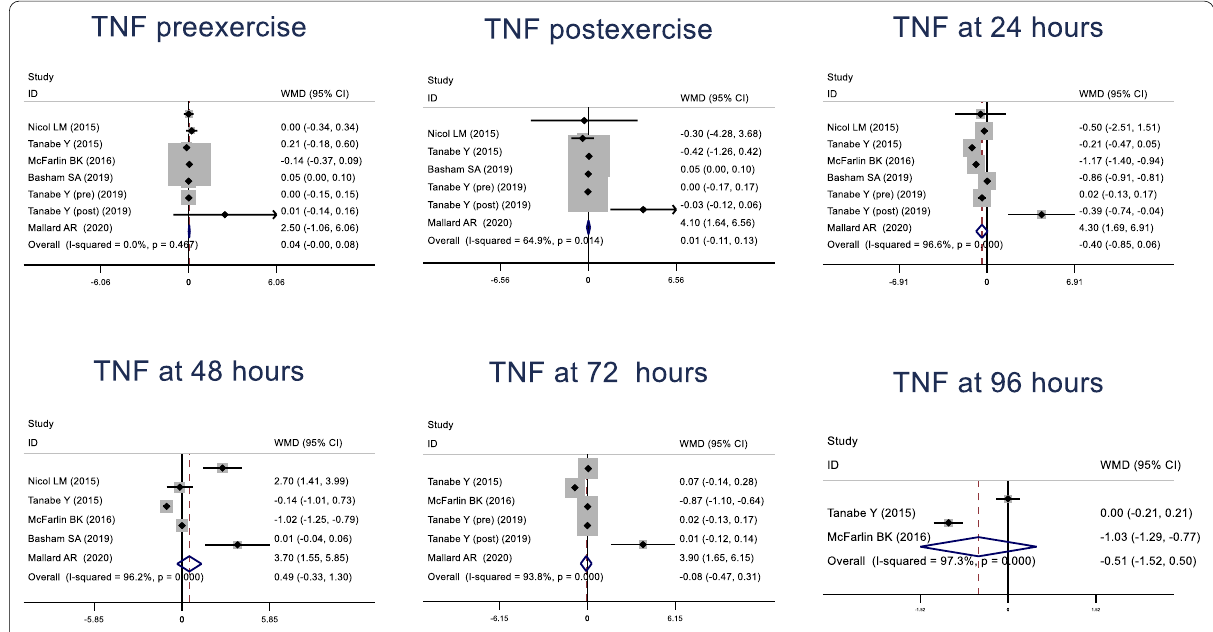
Fig. 4 Forest plot for comparison of TNF score at pre-, post-, 24, 48, 72 and 96 h after exercise between curcumin supplement versus